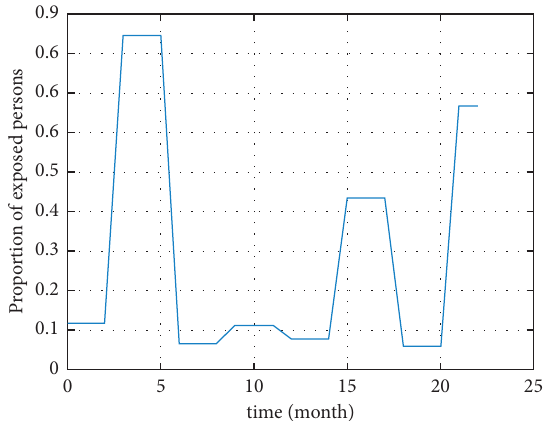
Figure 21: Proportion of the exposed people from March 2020 to January